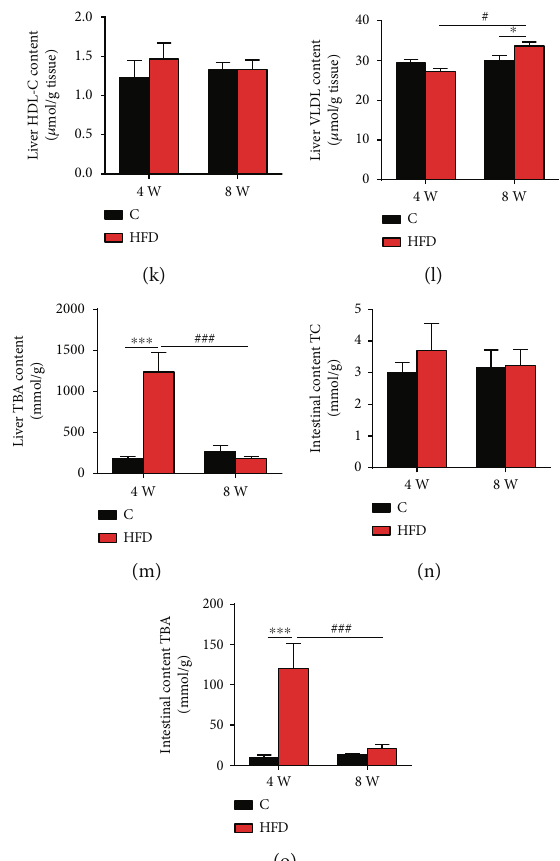
Figure 2: E ff ects of HFD on liver lipid pro fi le and total bile acids in the liver and intestinal content of Nile tilapia after 4-week and 8-week feeding trials. (a) Oil red O staining of liver, scale bars: 100 μ m ( n = 4 ); (b) liver malondialdehyde (MDA) content ( n = 9 ); (c) liver superoxide dismutase (SOD) enzyme activity ( n = 9 ); (d) liver lipid content ( n = 9 ); (e, f) liver triglyceride (TG) content and free fatty acid (FFA) contents ( n = 9 ); (g – i) liver total cholesterol (TC), free cholesterol (FC), and cholesterol ester (CE) contents ( n = 9 ); (j – l) liver low-density lipoprotein cholesterol (LDL-C), high-density lipoprotein cholesterol (HDL-C), and very-low-density lipoprotein (VLDL) contents ( n = 9 ); (m) liver total bile acid (TBA) content ( n = 9 ); (n, o) TC and TBA contents in intestinal content ( n = 9 ). Data are represented as means ± SD ; asterisks indicate the di ff erences between the C and HFD groups in the same feeding trial, ∗ P < 0 : 05 , ∗∗ P < 0 : 01 , ∗∗∗ P < 0 : 001 ; hash symbols indicate the di ff erences between 4-week and 8-week feeding trials of the same lipid level diet, # P < 0 : 05 , ## P < 0 : 01 , ### P < 0 : 001 ; C: control diet; HFD: high-fat